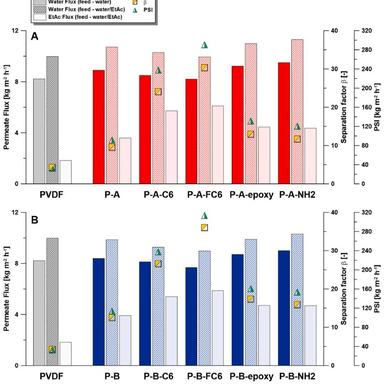
Membrane performance in membrane distillation – transport and separation properties. A – membrane activated with acid piranha, B - membrane activated with base piranha.